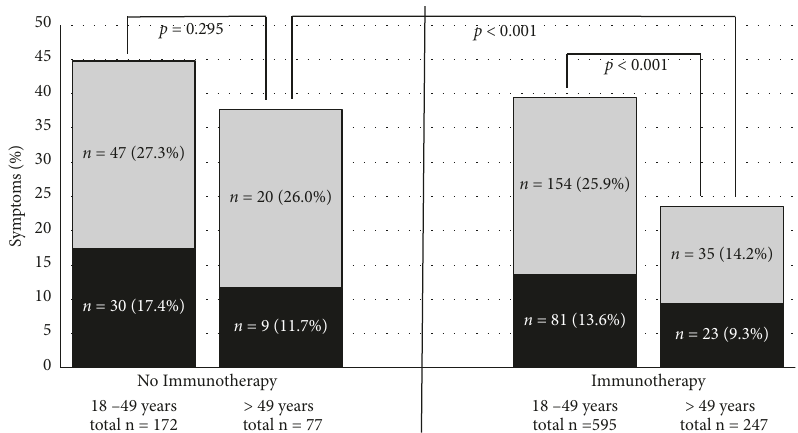
Figure 3: Symptoms of respiratory tract infections: moderate in grey (cough, rhinitis, and sore throat) and severe in black (fever, chills, and anosmia) in patients without (left) or with immunotherapy (right) according to the patients’ age. Old patients with immunotherapy show less symptoms than old patients without immunotherapy ( p < 0 . 001). Further, old patients with immunotherapy show less symptoms than young patients with immunotherapy ( p < 0 . 001). Older IBD patients without immunotherapy had not more symptoms than younger IBD patients without immunotherapies ( p � 0 . 295). Table 4: Patients’ characteristics with positive SARS-CoV-2 Ig tests. Patients in bold were swab test positive. Age in Patients